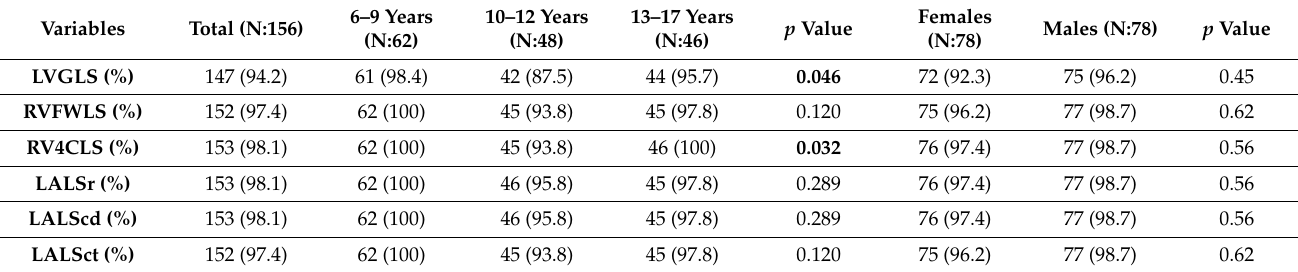
Table 3. The feasibility of the strain analysis categorized by age and